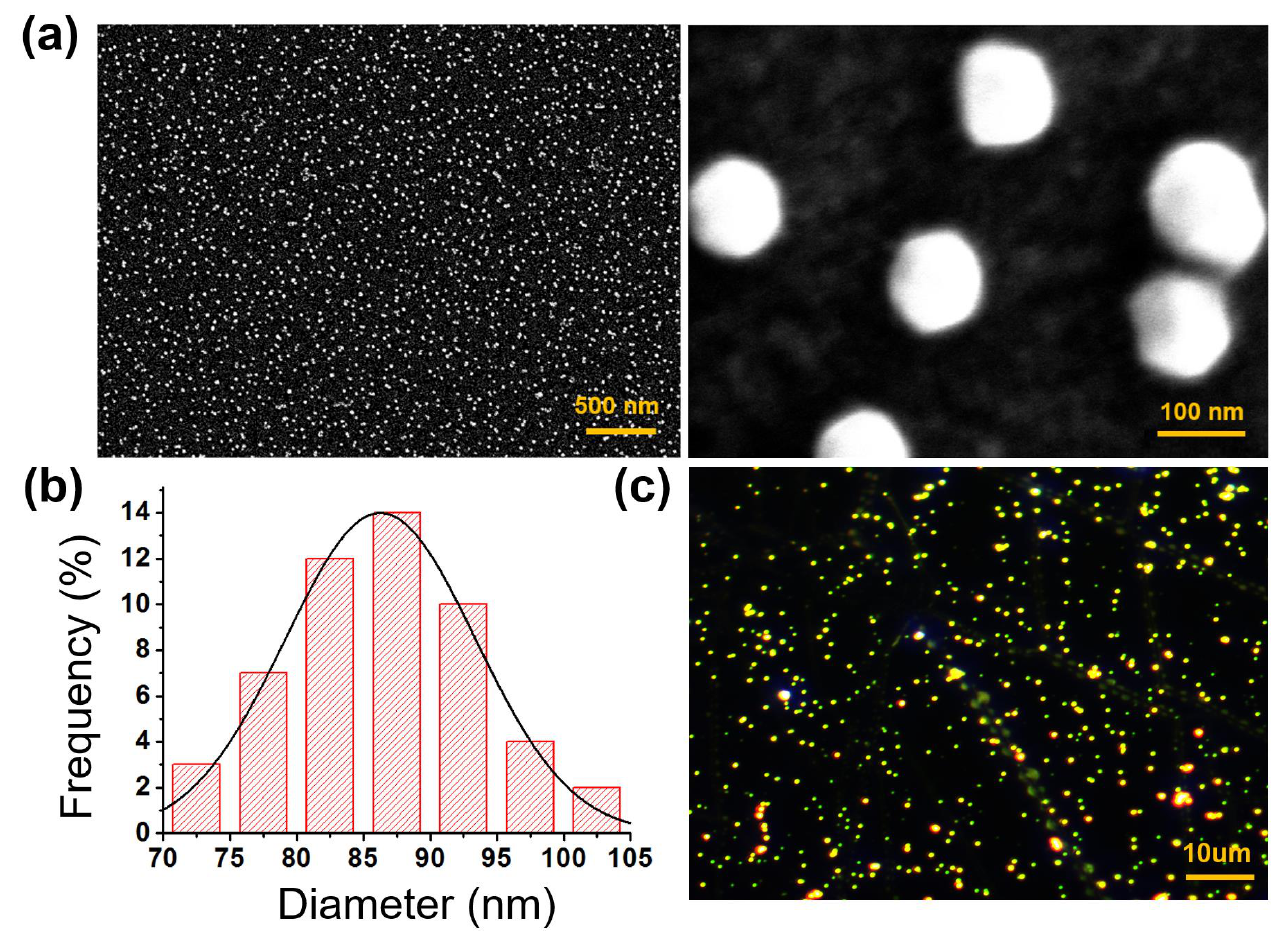
Figure 2. ( a ) SEM images, ( b ) frequency distribution curve, and ( c ) DFM of the flexible biosensor constructed using 80 nm AuNPs.